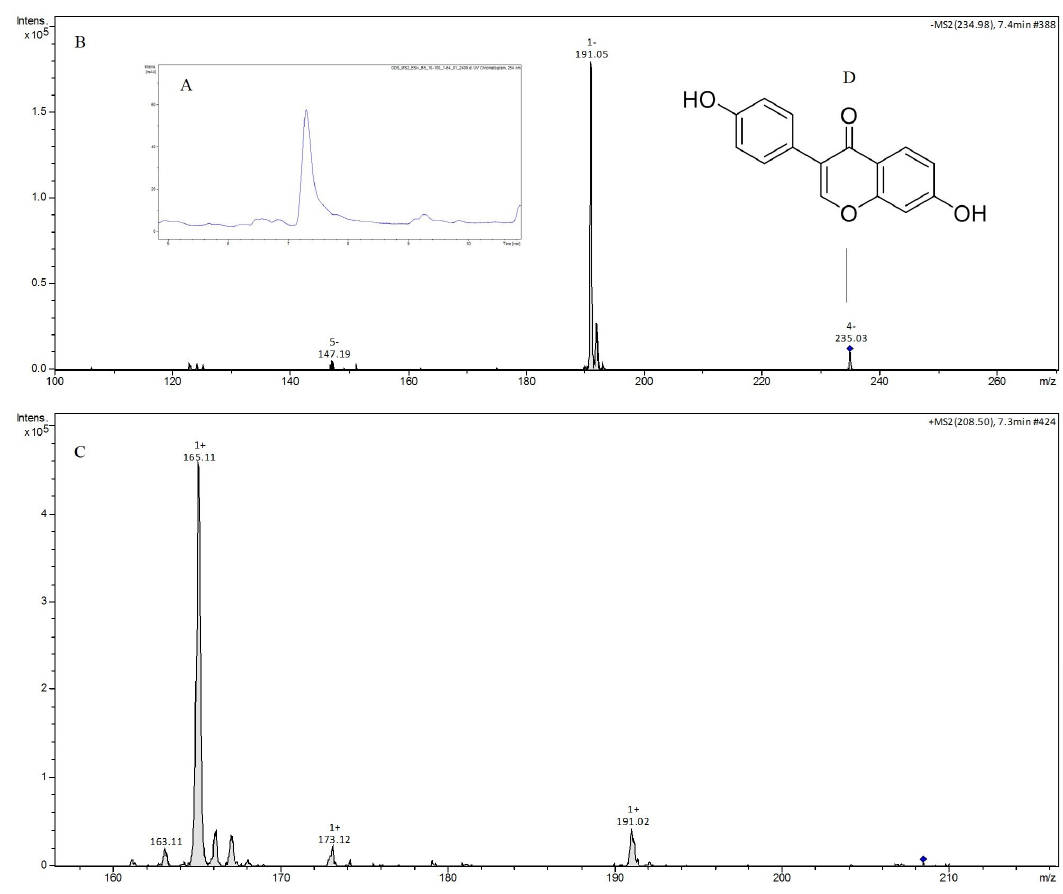
Figure A5. ( A ) Peak of the MS2 spectrum; ( B ) MS2 spectrum of [M − H] m / z 234 in negative mode; ( C ) [M + H] m / z 208 in positive mode of compound 3 from LC-MS/MS analysis of EtOAc extract produced by A. stygium WL1B5. ( D ) Daidzein.